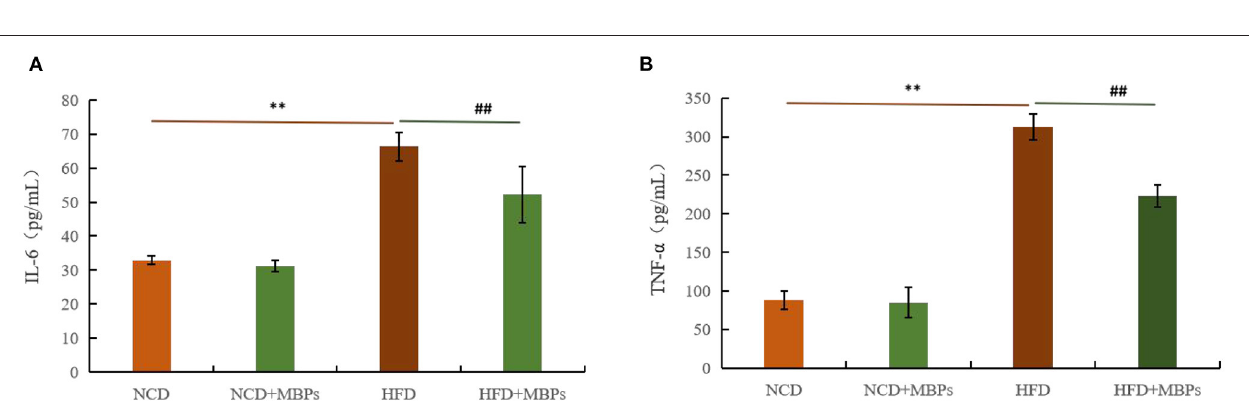
FIGURE 5 | Effects of MBPs on (A) IL-6 levels and (B) TNF- α levels. Data were presented as the mean ± SD ( n = 6). ** P < 0.01, NCD compared with HFD mice. ## P < 0.01, HFD compared with HFD + MBPs